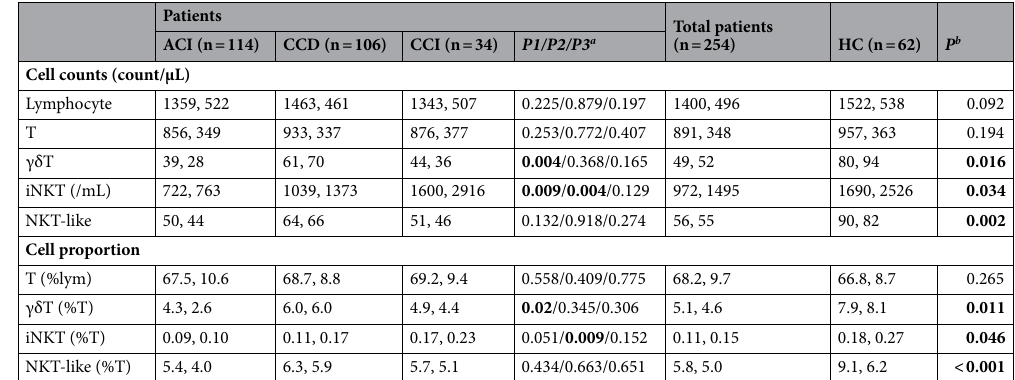
Table 2. Profiles of peripheral immune cell subsets in patients and healthy controls. Significant values are in bold. a P values from comparisons within ischemic groups. P1 , ACI vs CCD; P2 , ACI vs CCI; P3 , CCD vs CCI. b P values from comparisons of all patients and the healthy control group. Data were presented as Mean, SD. ACI acute cerebral infarction, CCD chronic cerebrovascular disease, CCI chronic cerebral circulation insufficiency, HC healthy control, lym lymphocyte.